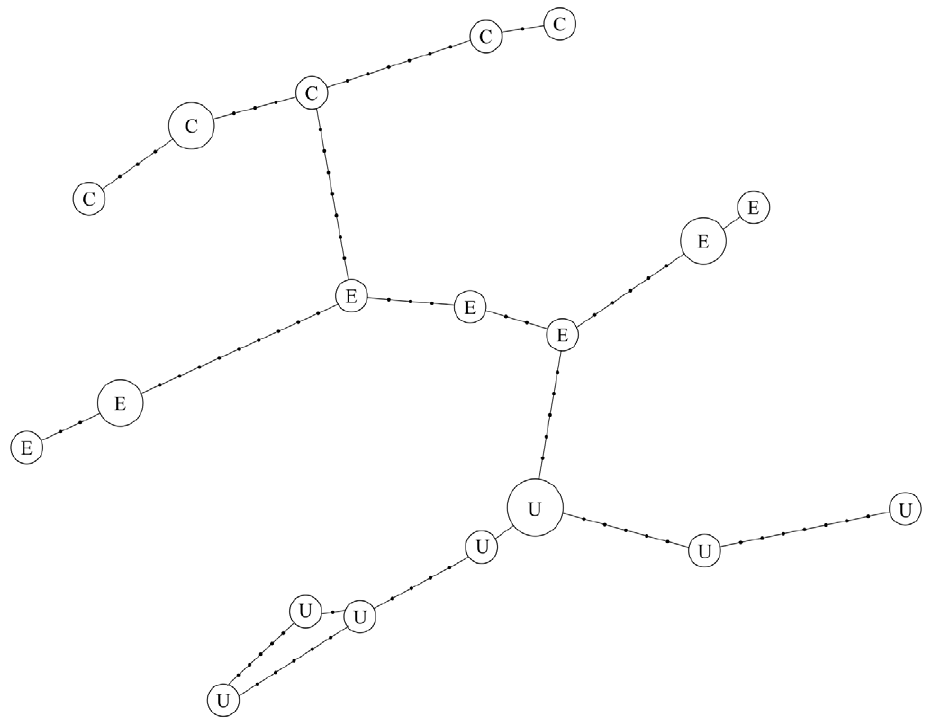
Figure 7. Haplotype network of cloned EF-1 a sequences from N.bombycis isolates. Branch lengths are proportional to the number of mutations separating haplotypes. Areas of circles are proportional to the number of clones containing each haplotype. Isolates are labelled as follows: E=England, U=USA, C=China. doi:10.1371/journal.pone.0055878.g007 PLOS ONE |